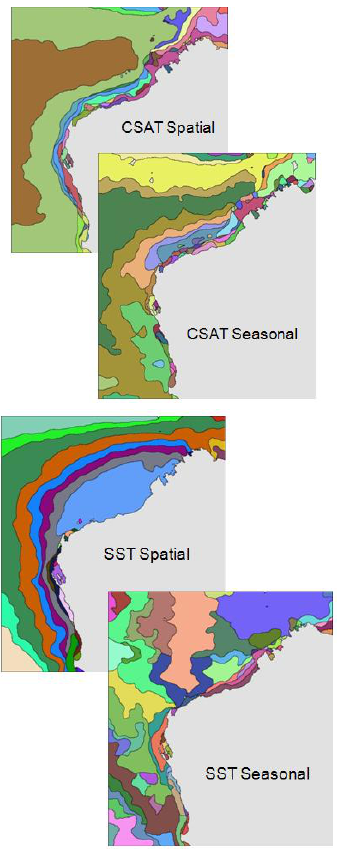
Figure Four: Australian West Coast Boundaries The process used to assess the accuracy of the classification in this study is as follows: the basic regional mean (µx) and standard deviations (sx) were calculated using the individual components used to derive regional boundaries.